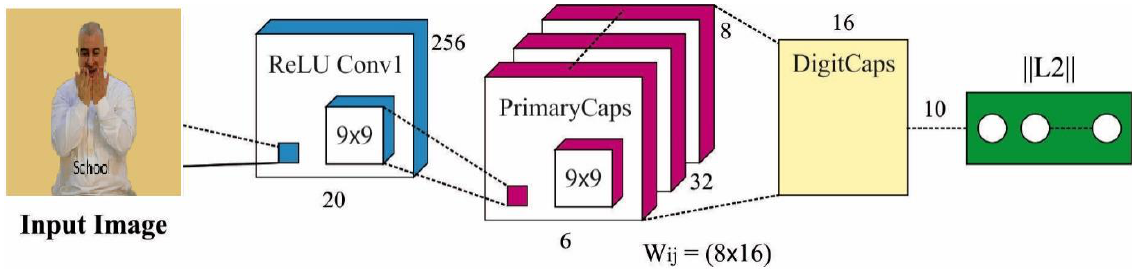
Figure 1. Structure of CapsNet model.